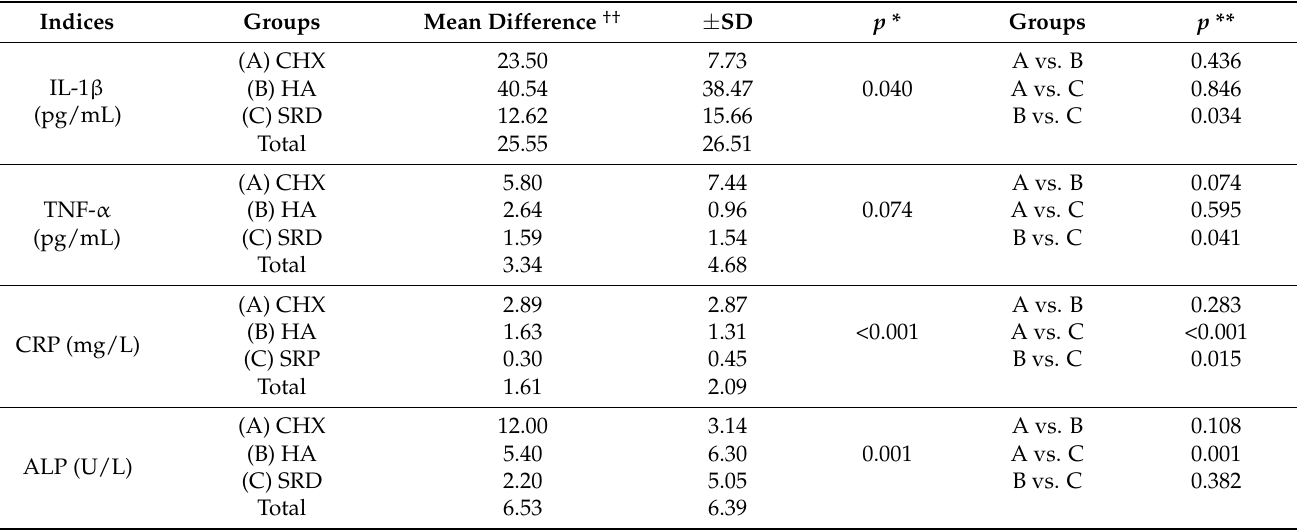
Table 4. The mean differences in the biochemical parameters (before and after